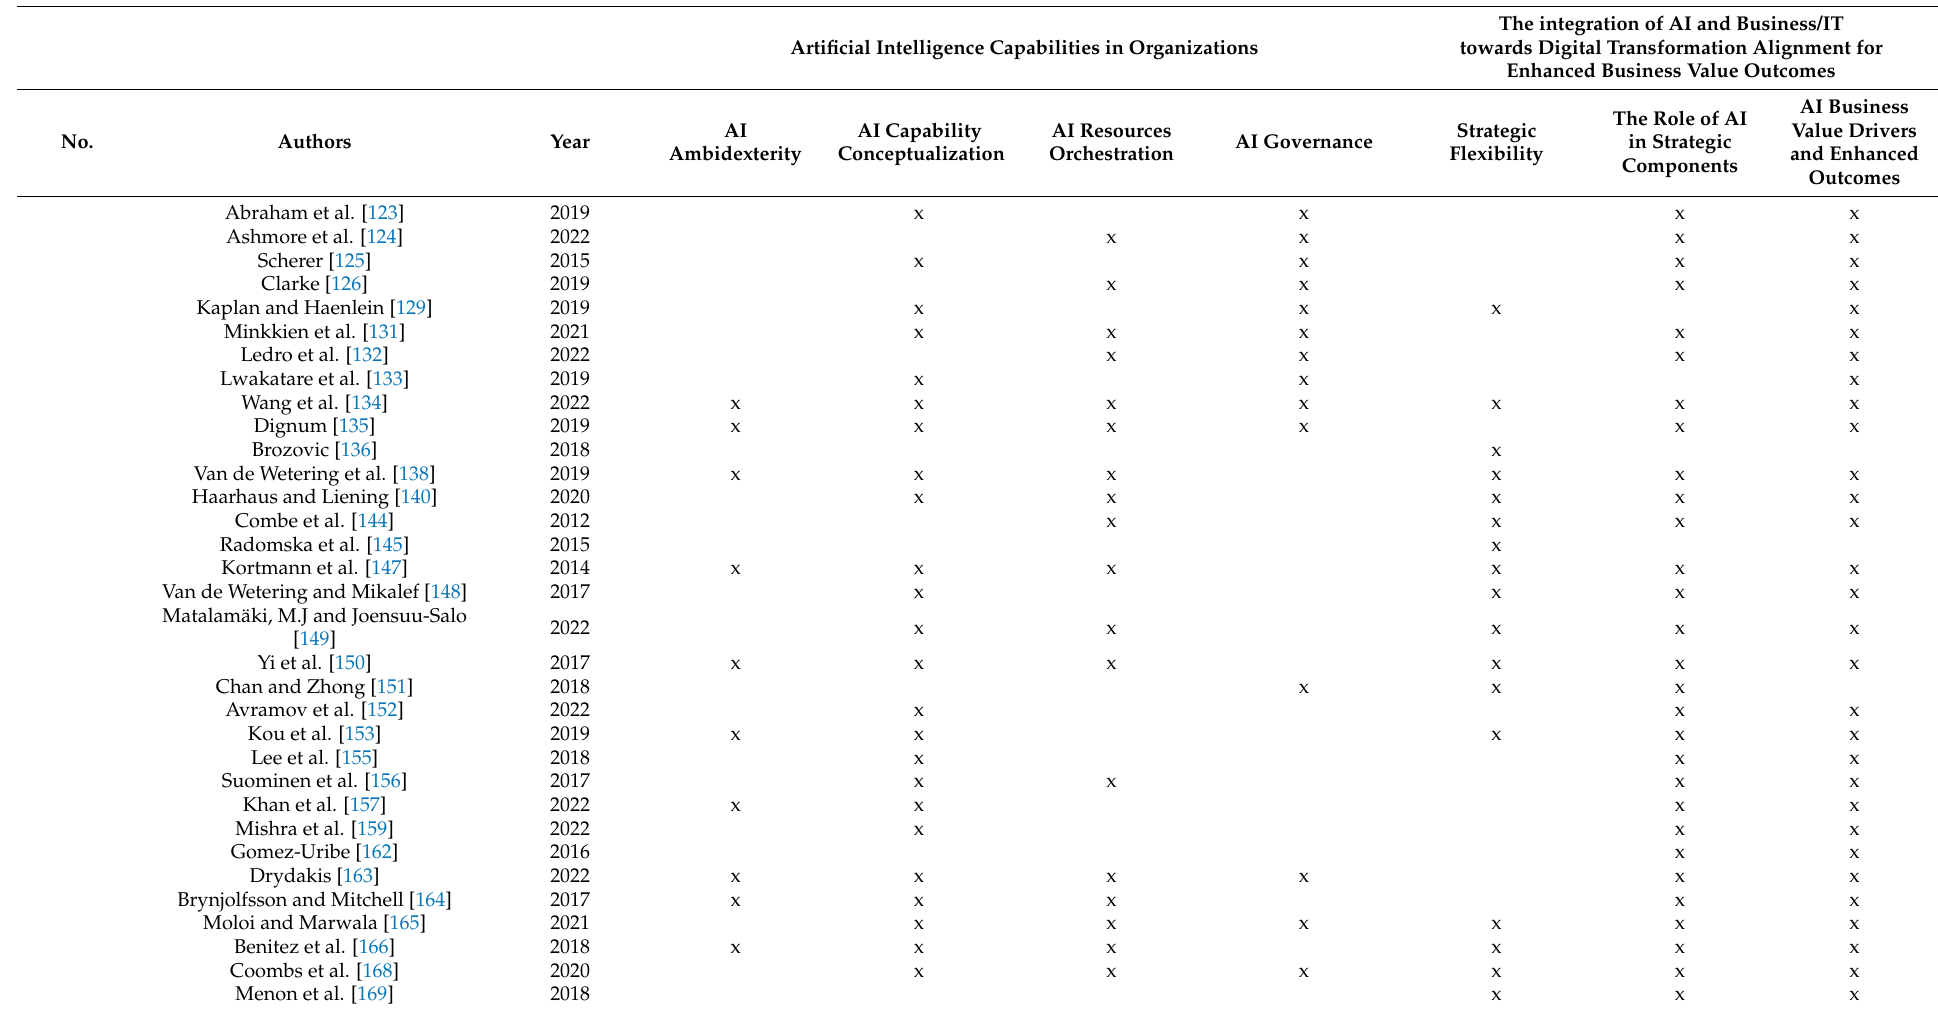
Table A4. Concept matrix table. Source: Own